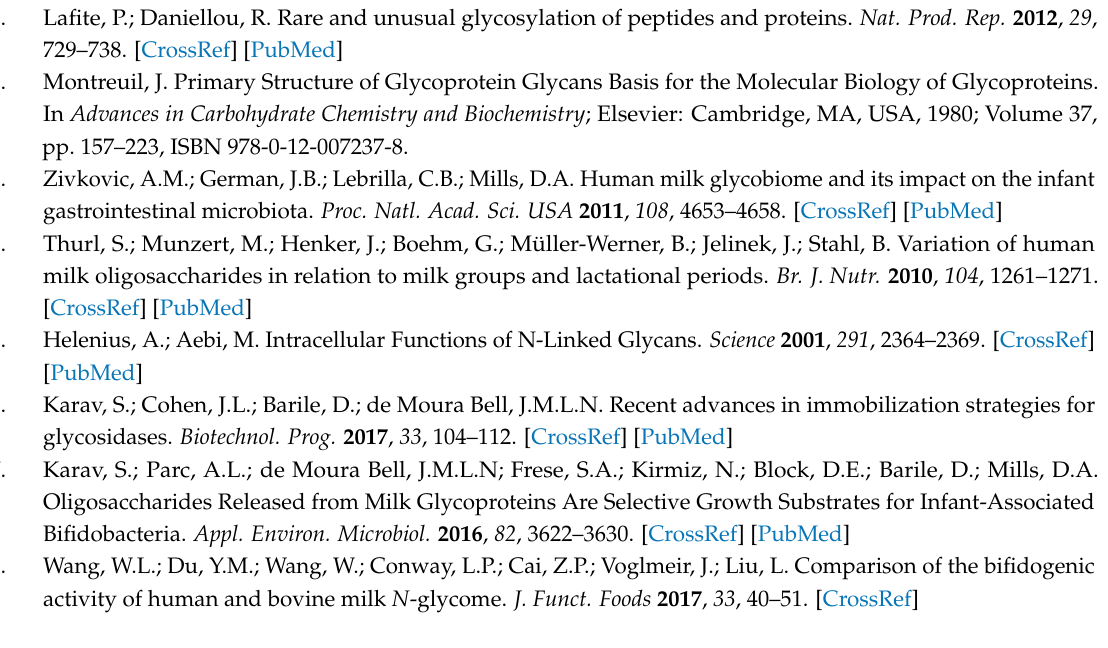
Figure S1: Sodium dodecyl sulfate polyacrylamide gel electrophoresis of immobilization washings from amino, adsorption, and epoxy methods on a 4–15% acrylamide gel. Endo BI-1 weighs approximately 53 kDa, Figure S2: Normalized MALDI-ToF MS intensity vs. N glycan: I.S. ratio for glycans released from RNase B, Table S1: Mean relative quantities ( ± S.D.) of N -glycans released by free and immobilized Endo BI-1 from bovine colostrum whey proteins as determined by nano-LC Chip Q-ToF MS/MS Compound formula is signified by the number of residues of each monosaccharide in the following order: